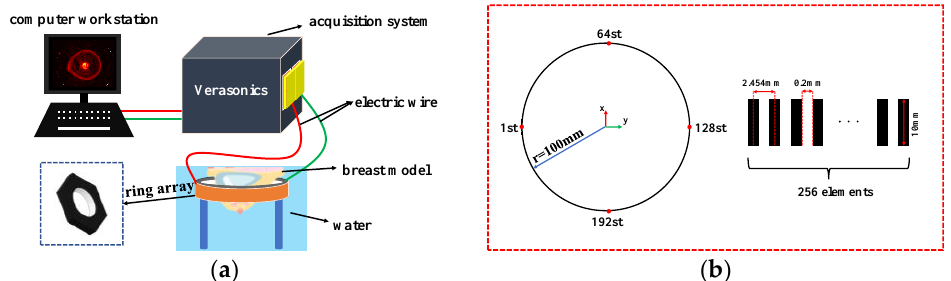
Figure 1. Schematic diagram of the ring array data acquisition system. ( a ) Schematic of the US imaging system based on the ring array. ( b ) Element parameters in the ring array.